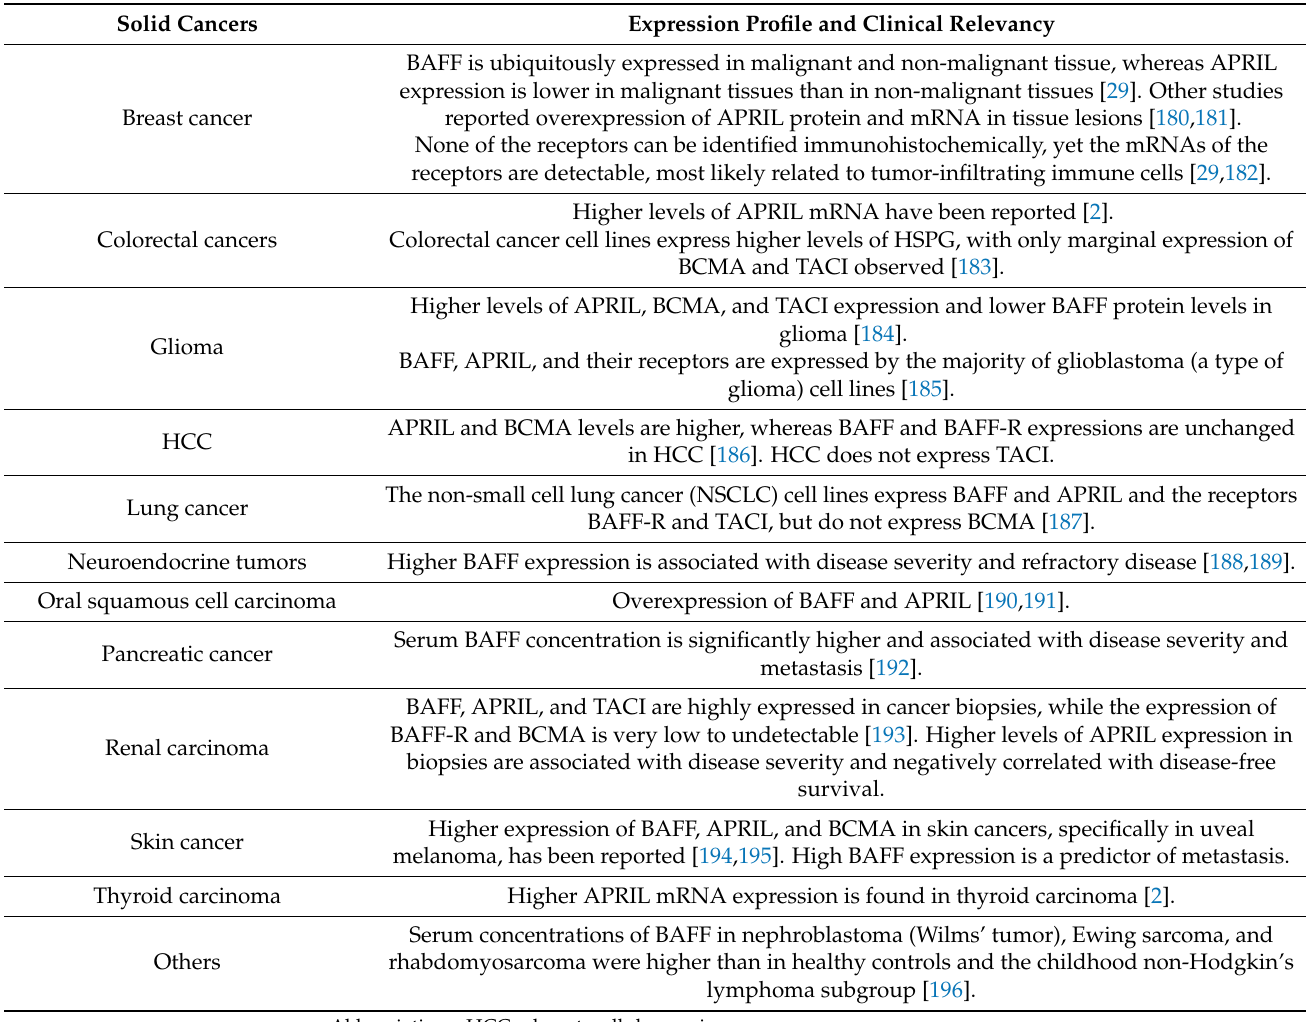
Table 2. Expression profile of BAFF and APRIL system in solid